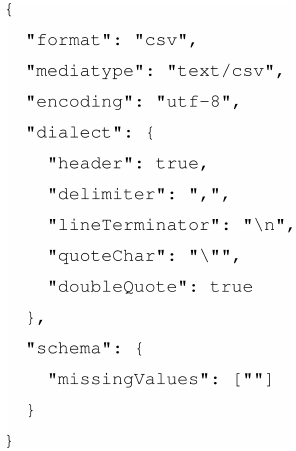
Figure 3. Sample JSON from datapackage.json specifying the file format (format: “csv”), character encoding (encoding: “utf- 8”), and structure of the data files – for example, that the first line of each file contains field names (header: true), values are separated by a comma (delimiter: “,”), and missing values are exclusively rep- resented by empty strings (missingValues: